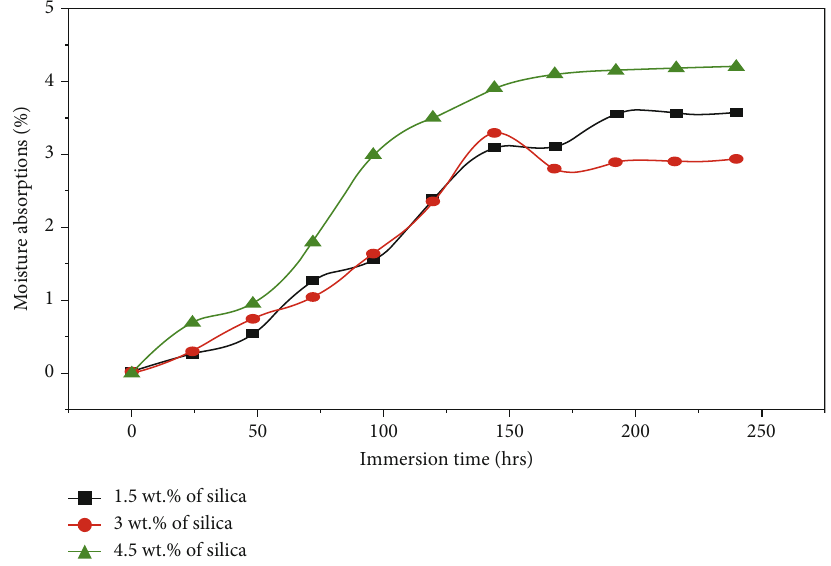
Figure 11: Moisture absorption characteristics of nanocomposite based on nanosilica fi ller